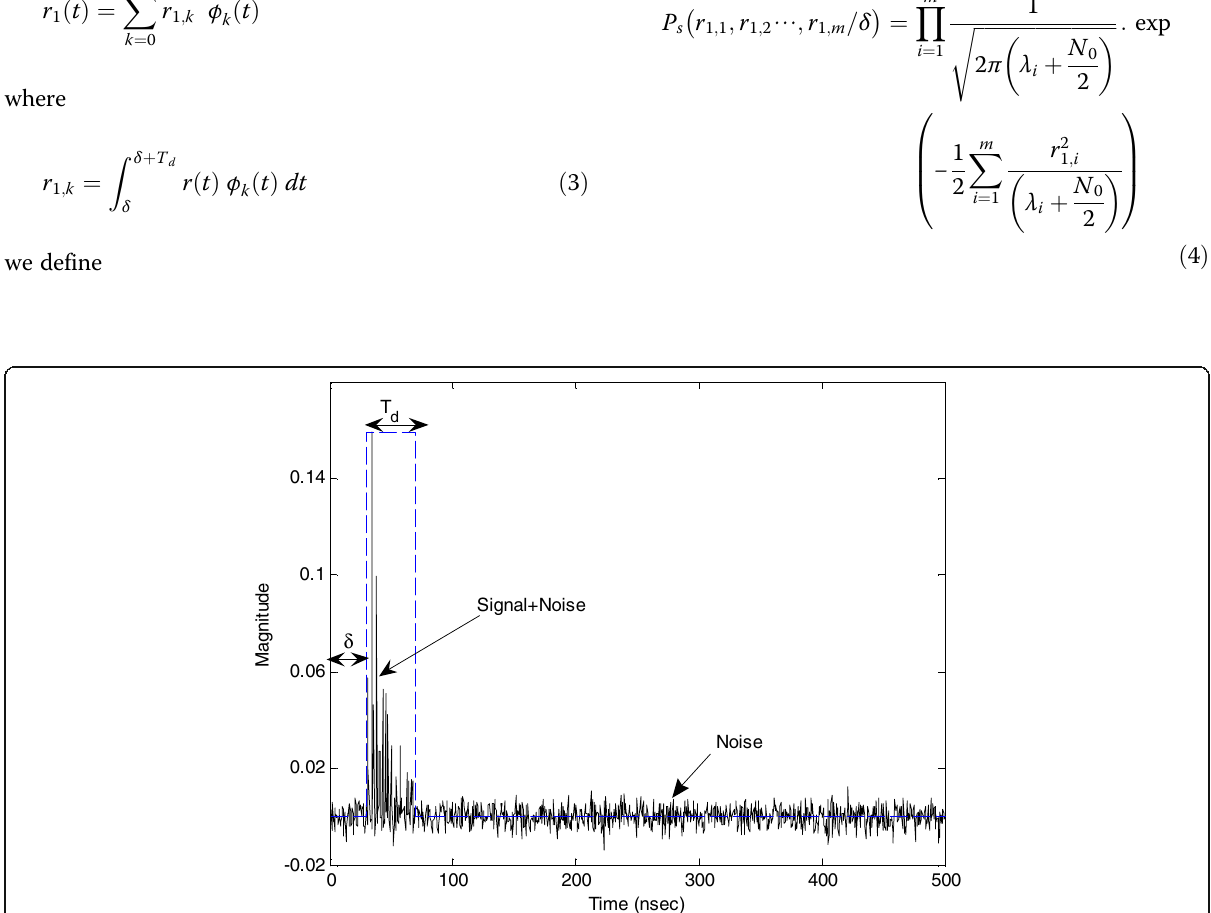
1 ffiffiffiffiffiffiffiffiffiffiffiffiffiffiffiffiffiffiffiffiffiffiffiffiffiffiffiffi